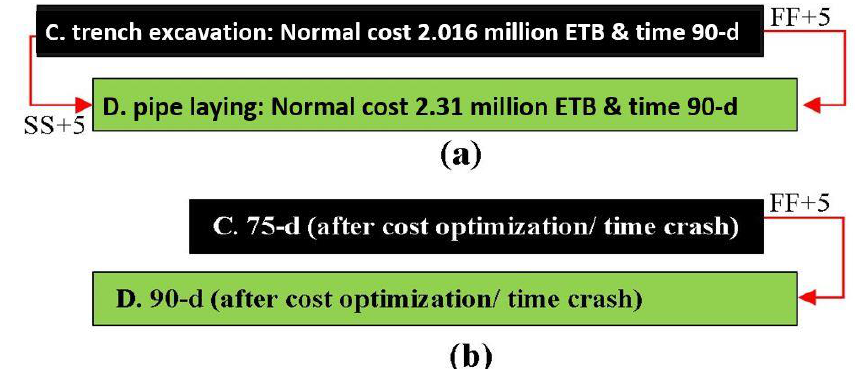
Fig. 2. Relation between activities; (a) double precedence, (b) single precedence after cost-time optimization (developed by the